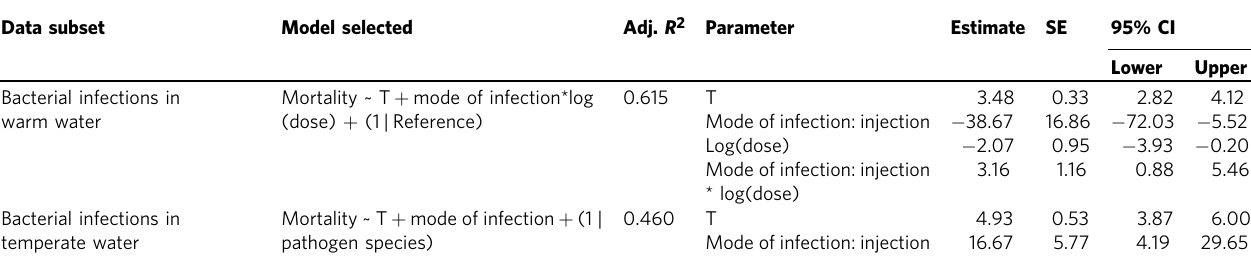
Table 1 Parameters from the selected linear mixed models (LMM) to test the relationship between aquatic animal mortality and temperature ( T ) under bacterial